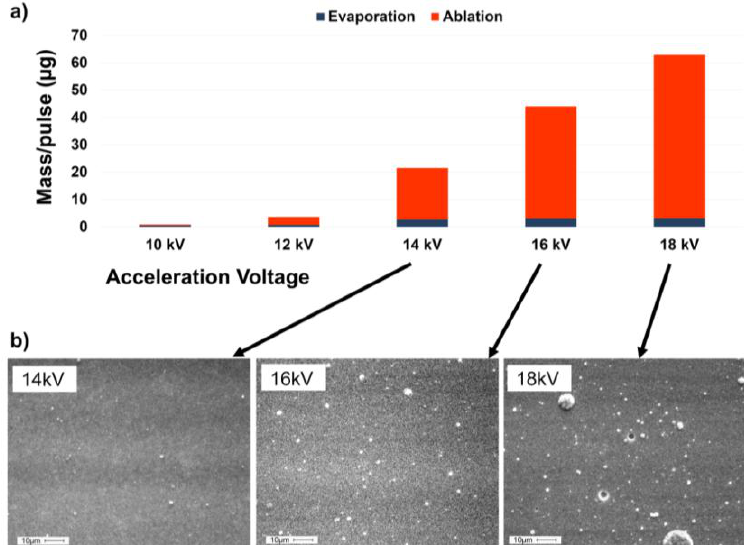
Figure 1. ( a ) Bar chart reporting the total deposition rate as a function of the electron beam energy. The blue and the orange sections of the bars represent the evaporated and the ablated fraction of the target material; ( b ) Scanning Electron Microscope images of the CIGS surface obtained with the electron source operating at 14 kV, 16 kV and 18 kV.